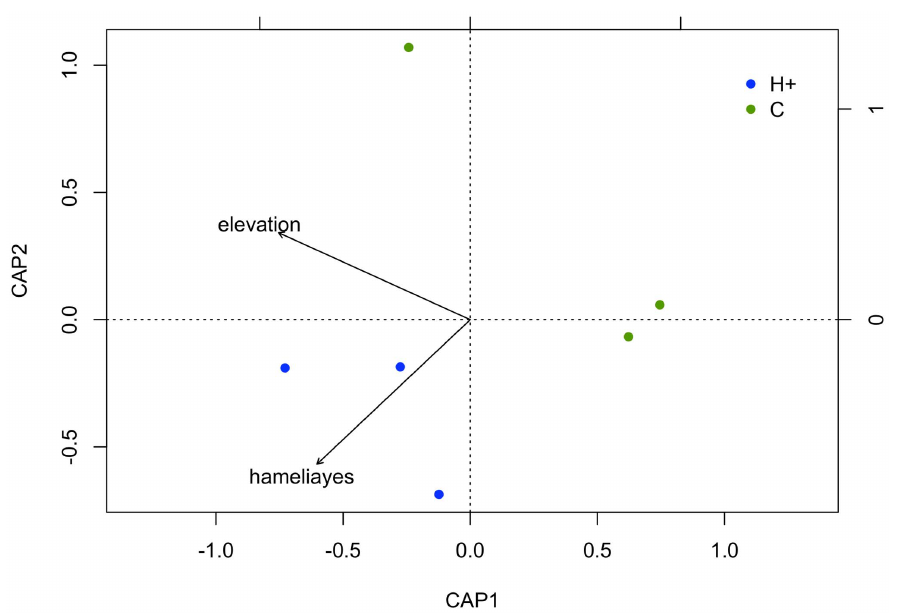
Figure 4. Ordination of the flower-visiting community in coffee agroforests. Distance-based Redundancy Analysis (RDA) of the entire flower-visiting community in coffee agroforests in Costa Rica. H + represents agroforests with supplemental H. patens plantings and C represents control agroforests. The ordination model included elevation and the presence of H. patens (represented by hameliayes arrow in graph) supplemental patches ( P =0.015).